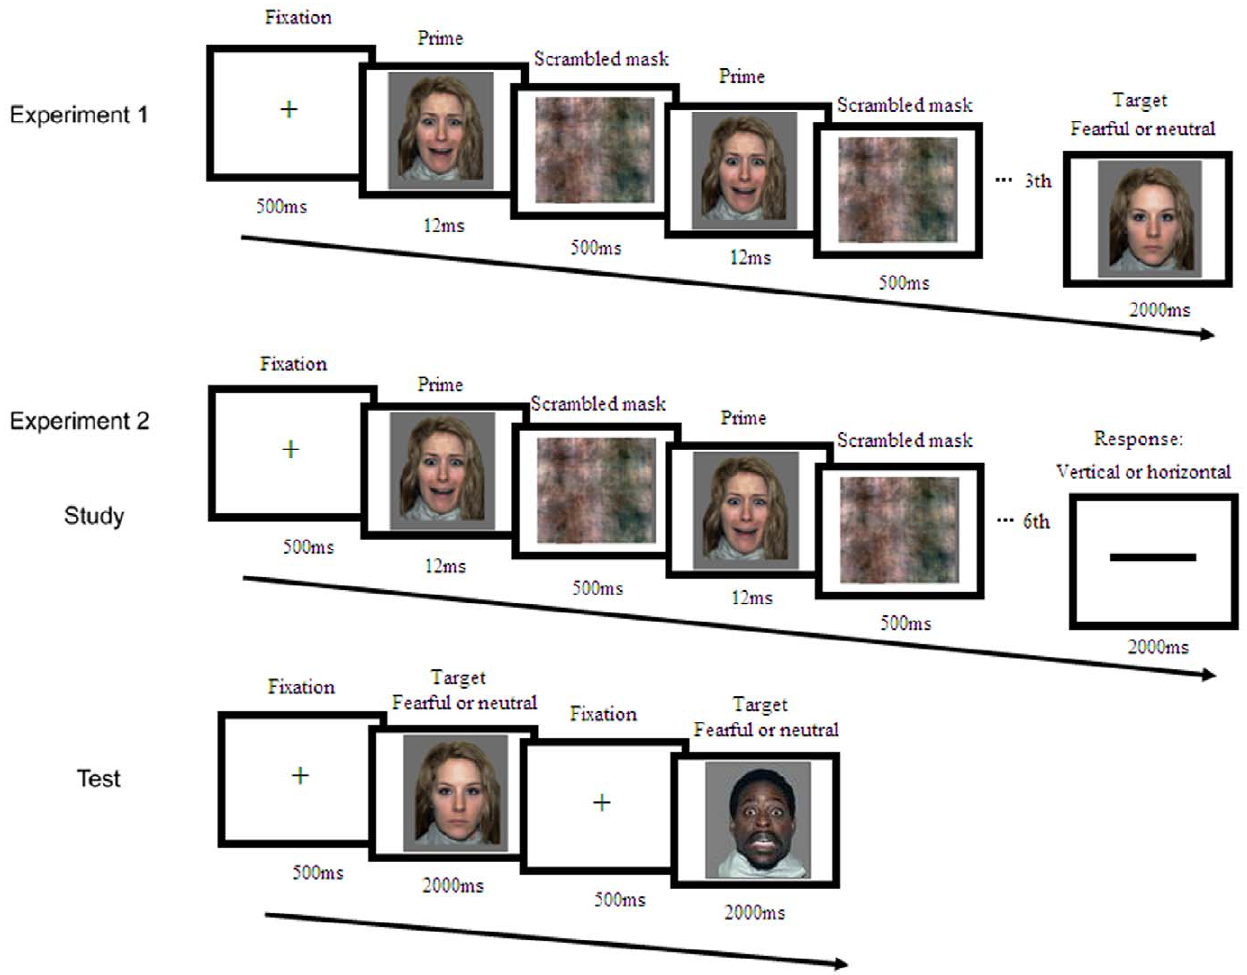
Figure 4. Experimental procedures for Experiment 1 and 2. In Experiment 1, the masked prime faces were presented for three times, and an emotional judgment was performed. In Experiment 2, the masked faces were presented for six times during study, and participants were asked to judge the orientation of the bar. The emotional judgment was performed three minutes after the study phase.